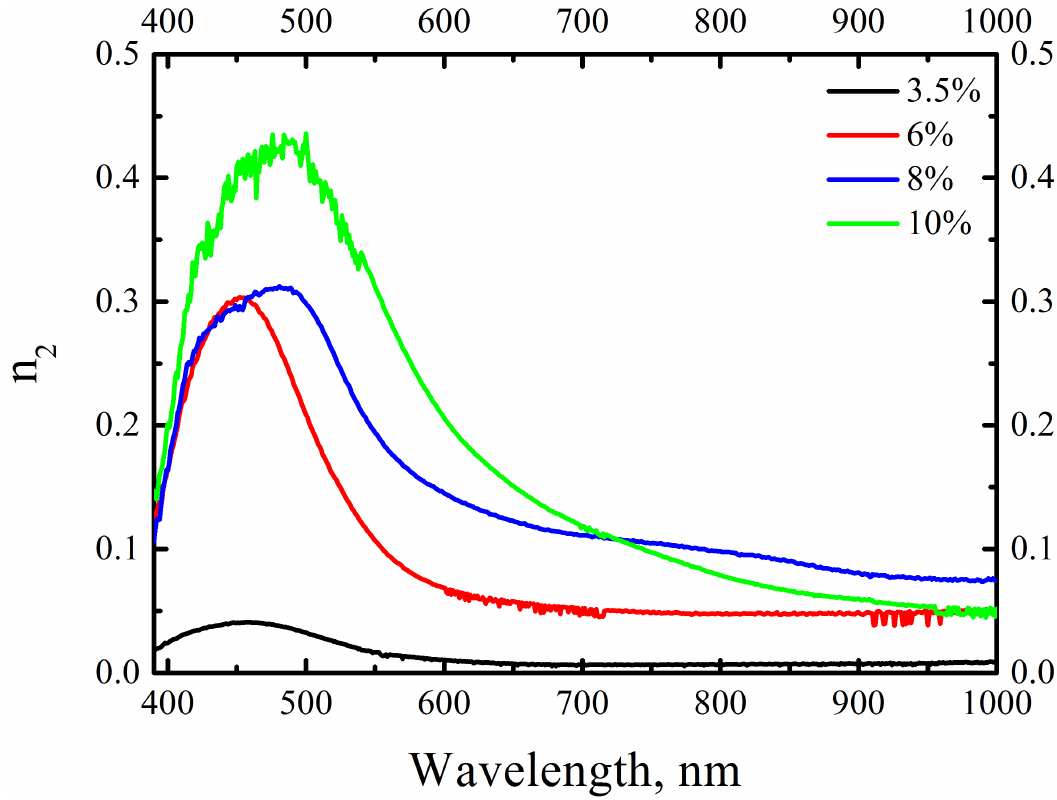
Figure 7. The imaginary part of the effective refractive index of PPX+Ag composite with different volume concentrations of silver: 3.5% (black), 6% (red), 8% (blue), 10%